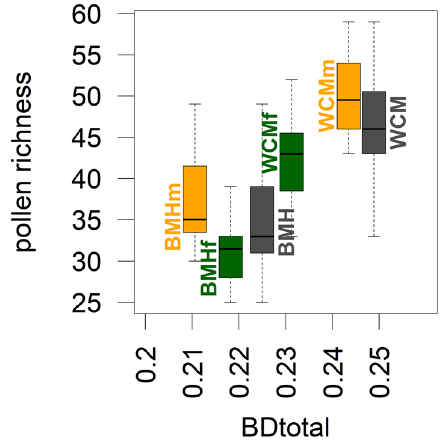
Figure 2. Pollen alpha diversity (pollen richness, y-axis) and beta diversity (BD Total , x-axis) in two study regions and their different habitats. Open habitats (yellow), forest (green), and both habitats together (black).